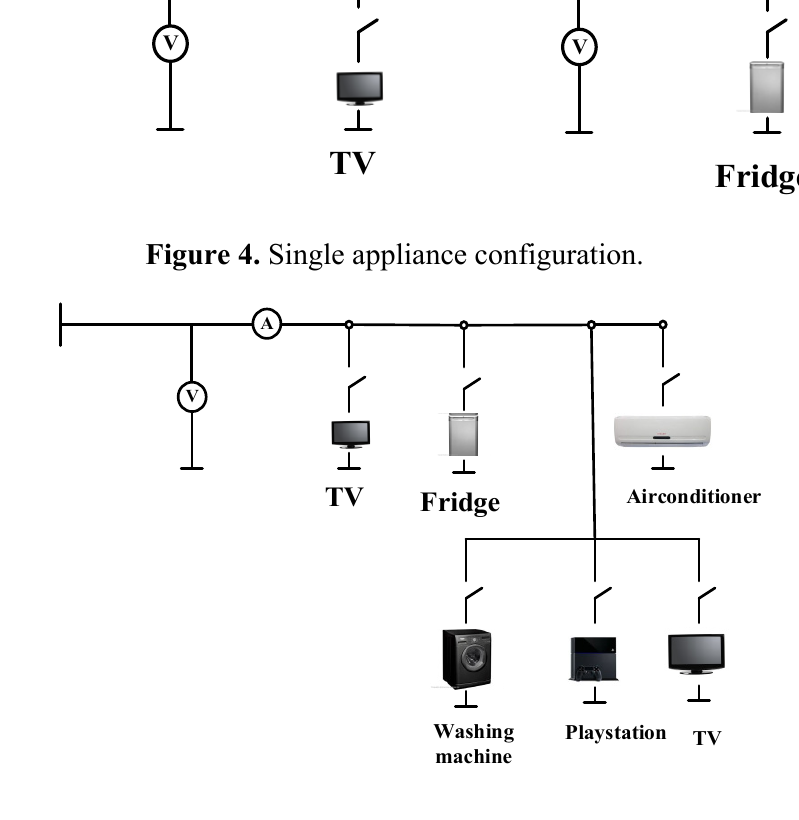
Figure 5. Multiple appliance